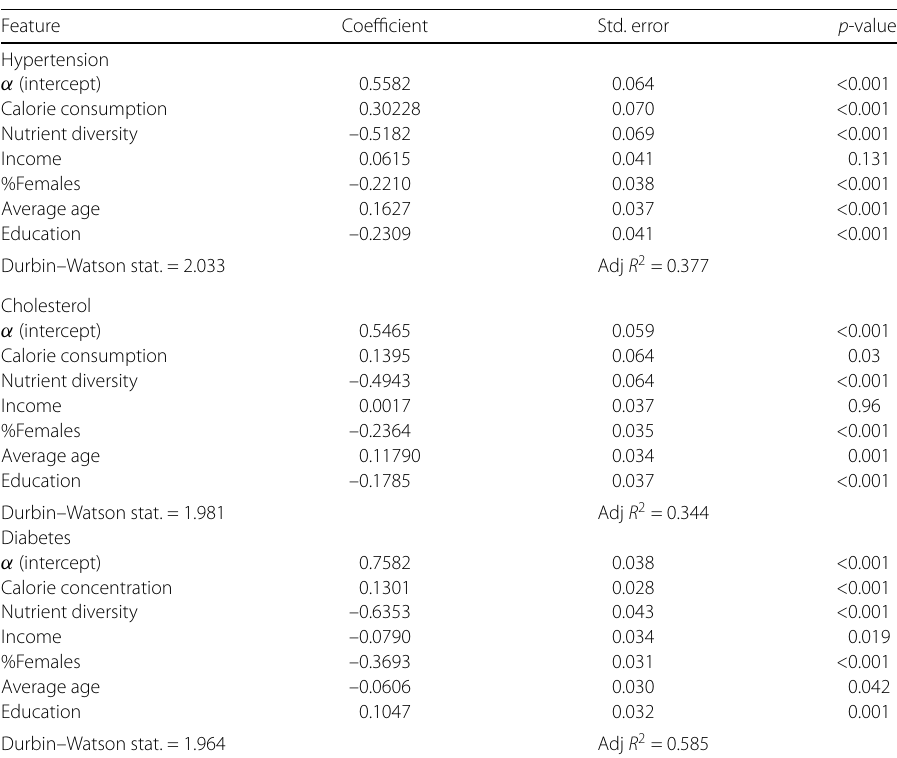
Table 2 Linear regressions that predict the three chronic diseases from item weight and nutrient diversity (plus control variables such as income, gender, age, education level) Feature Coefficient Std. error p -value Hypertension α (intercept)